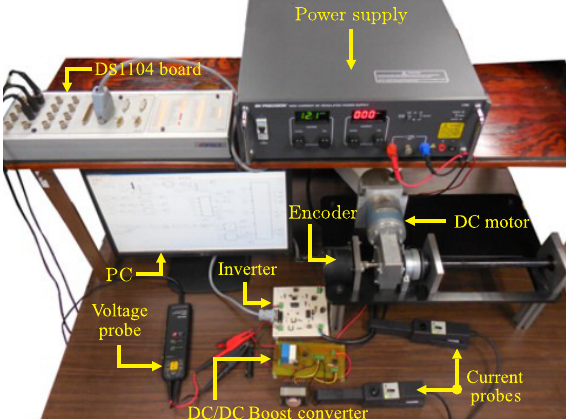
Figure 8. Built experimental